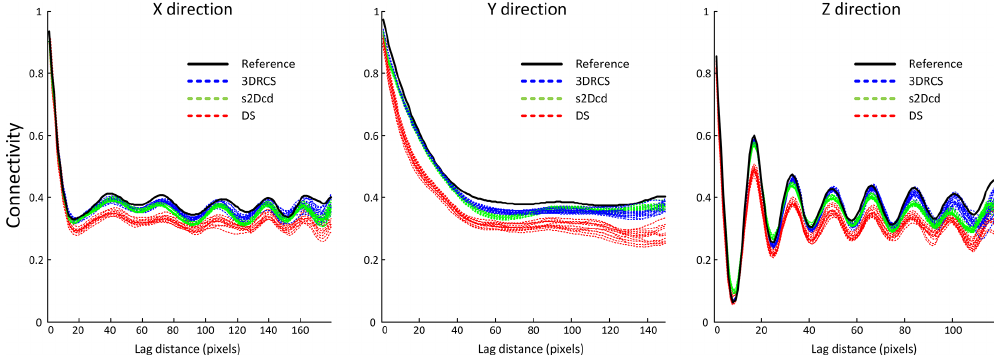
Figure 12. Comparison of the connectivity functions in three directions with three MPS methods.